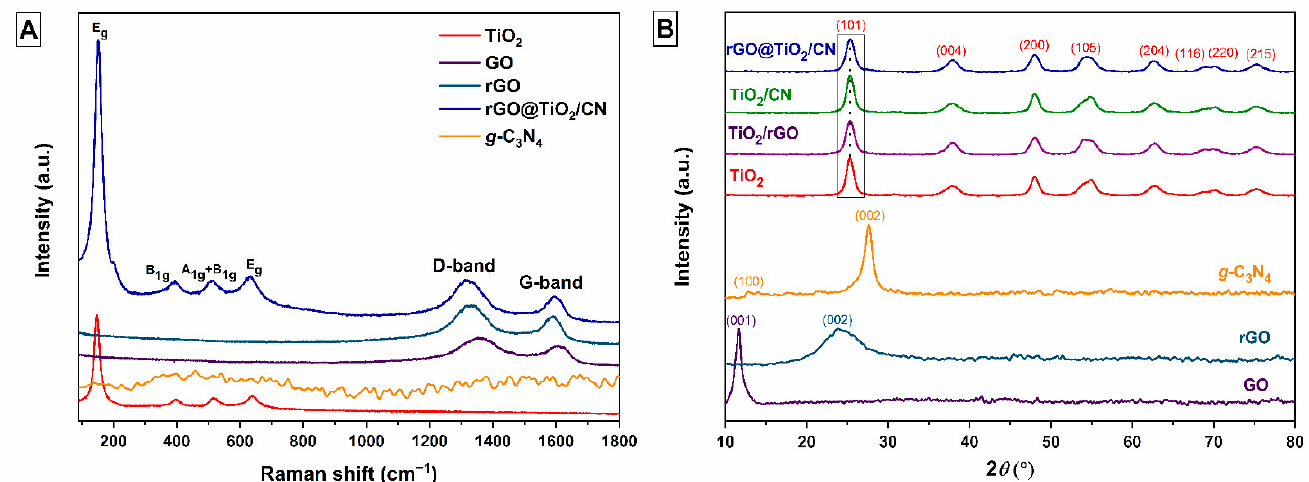
Figure 2. ( A ) Raman spectra of TiO 2 , GO, rGO, g -C 3 N 4 , and rGO@TiO 2 /CN nanocomposite, and ( B ) XRD patterns of the